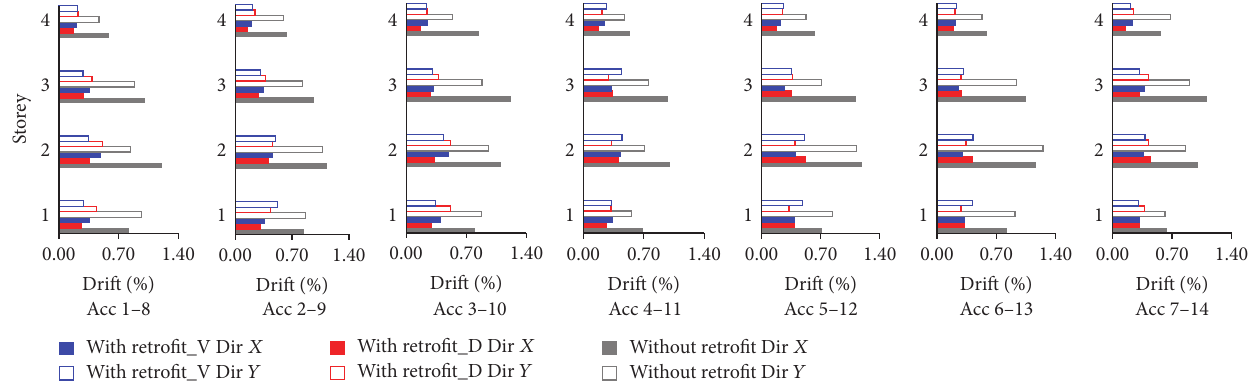
Figure 7: Maximum drifts obtained by NLDA on model with and w/o damped bracing systems.